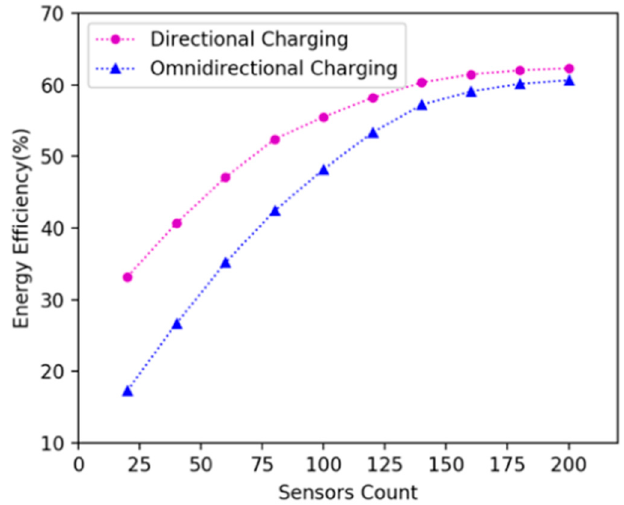
Figure 15. Energy efficiency of the DCV and omnidirectional charging vehicle in 20 × 20 m 2 area.